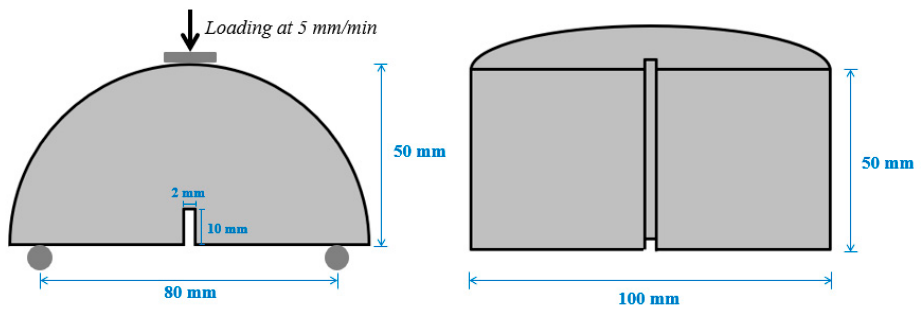
Figure 1. The semi-circular bending (SCB) sample dimensions.